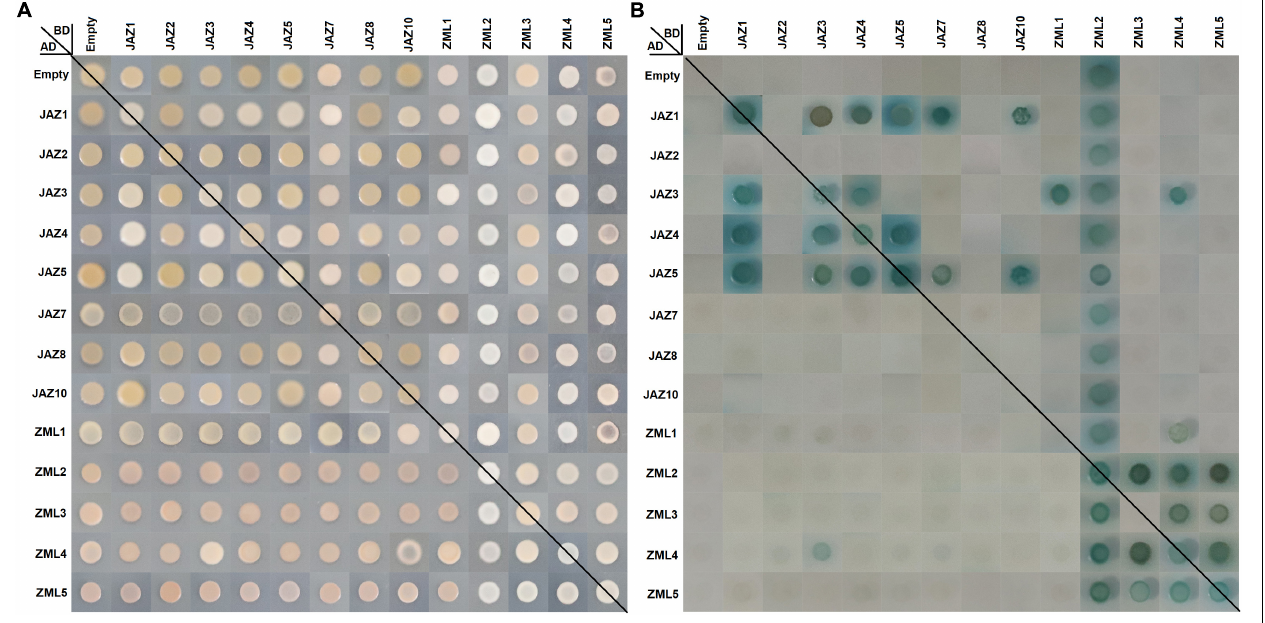
FIGURE 7 | Protein-protein interactions between peach JAZ and/or ZML proteins by yeast two-hybrid assay. The positive hybrid yeast cells were grown on SD-Trp-Leu medium (A) and SD-Trp-Leu-His-Ade + AbA medium supplemented with X- α -Gal (B) to check the interactions. For more details see the Section “Materials and